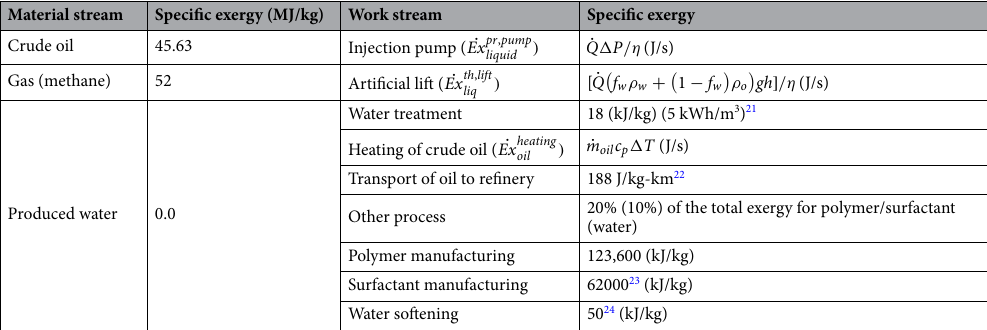
Table 1. Summary of the required exergy for material and work